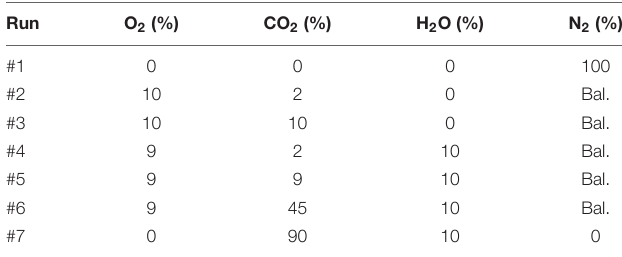
TABLE 1 | Gas compositions tested under this